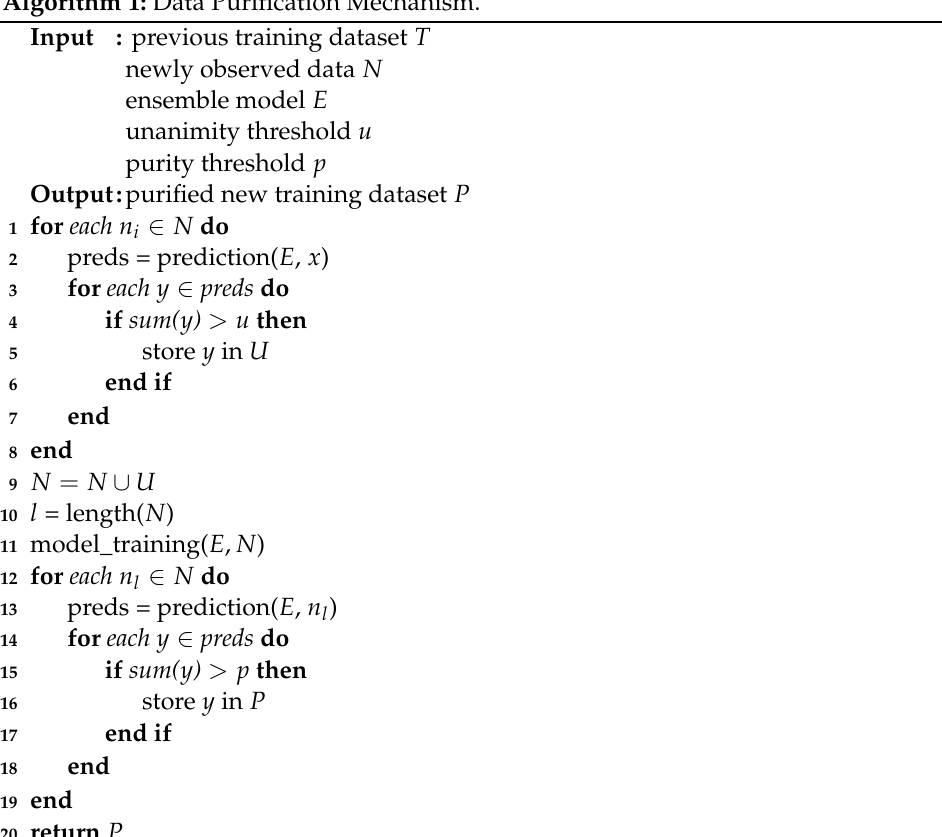
Algorithm 1: Data Purification